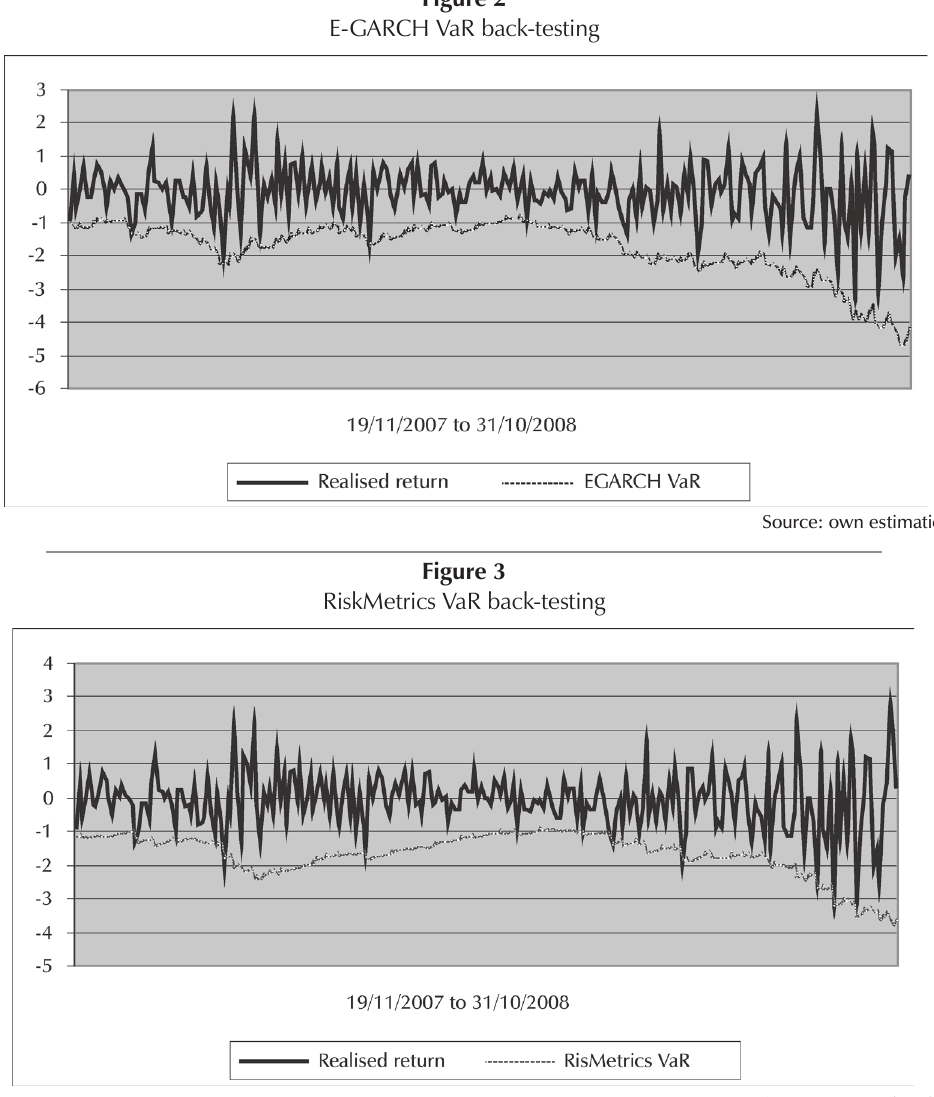
E-GARCH VaR back-testing